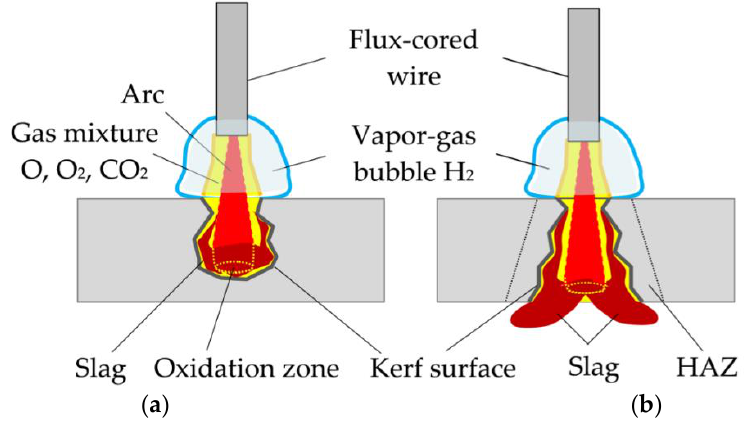
Figure 5. Model of arc penetration and stabilization during underwater wet arc cutting using a flux-cored wire in the cross-section: ( a ) closed kerf; ( b ) open kerf. (HAZ) Heat-affected zone.